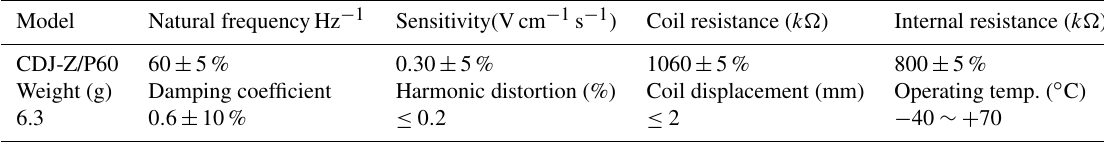
Table A1. Technical parameters of geophone